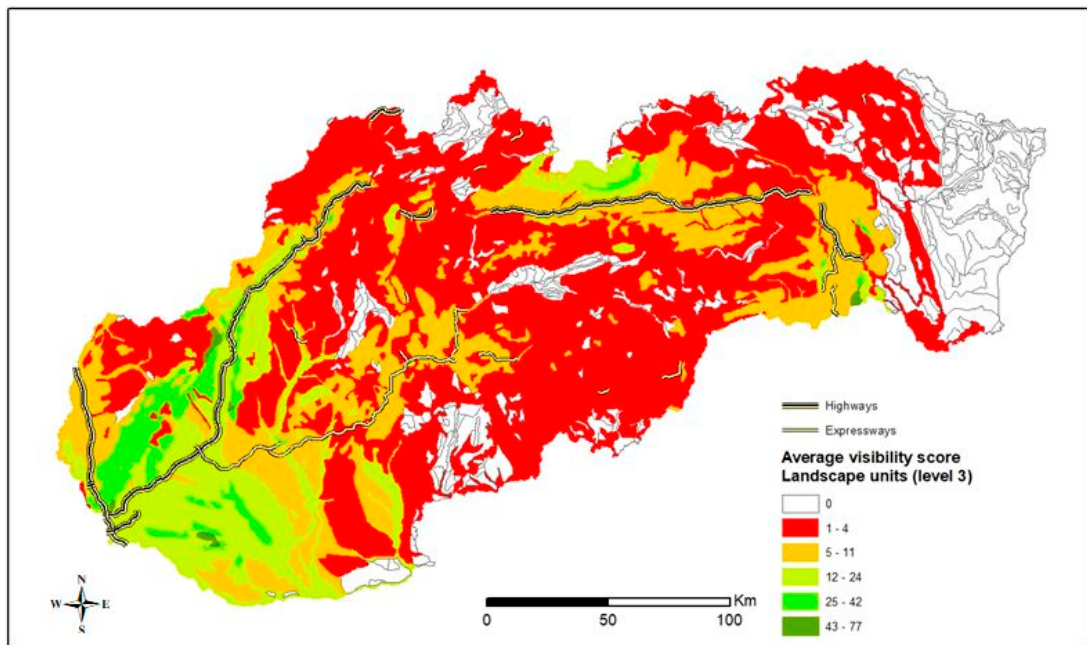
Figure 6. Visibility scores summarized per landscape unit (level 3).